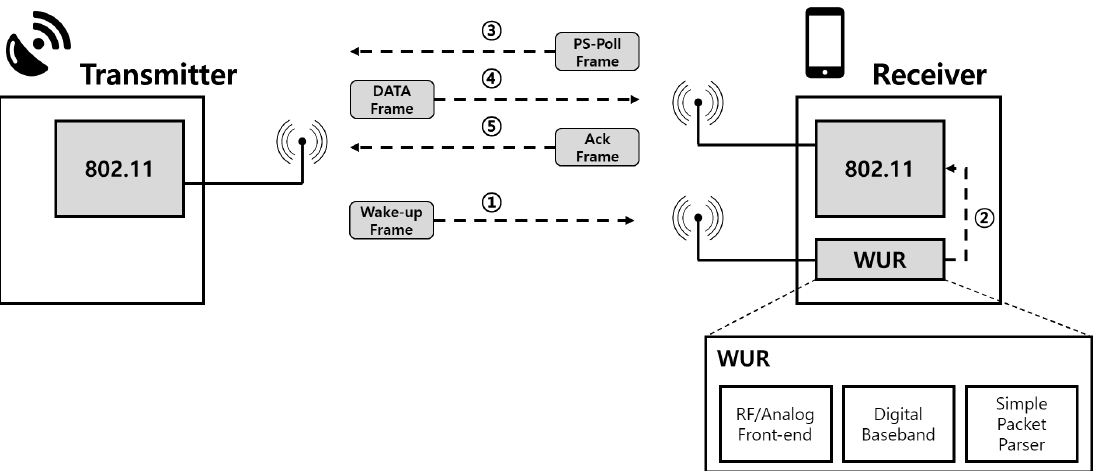
Figure 3. Architecture of IEEE